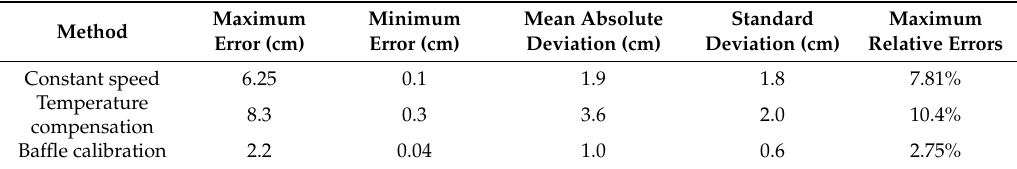
Table 3. Statistical analysis of measurement errors for the three